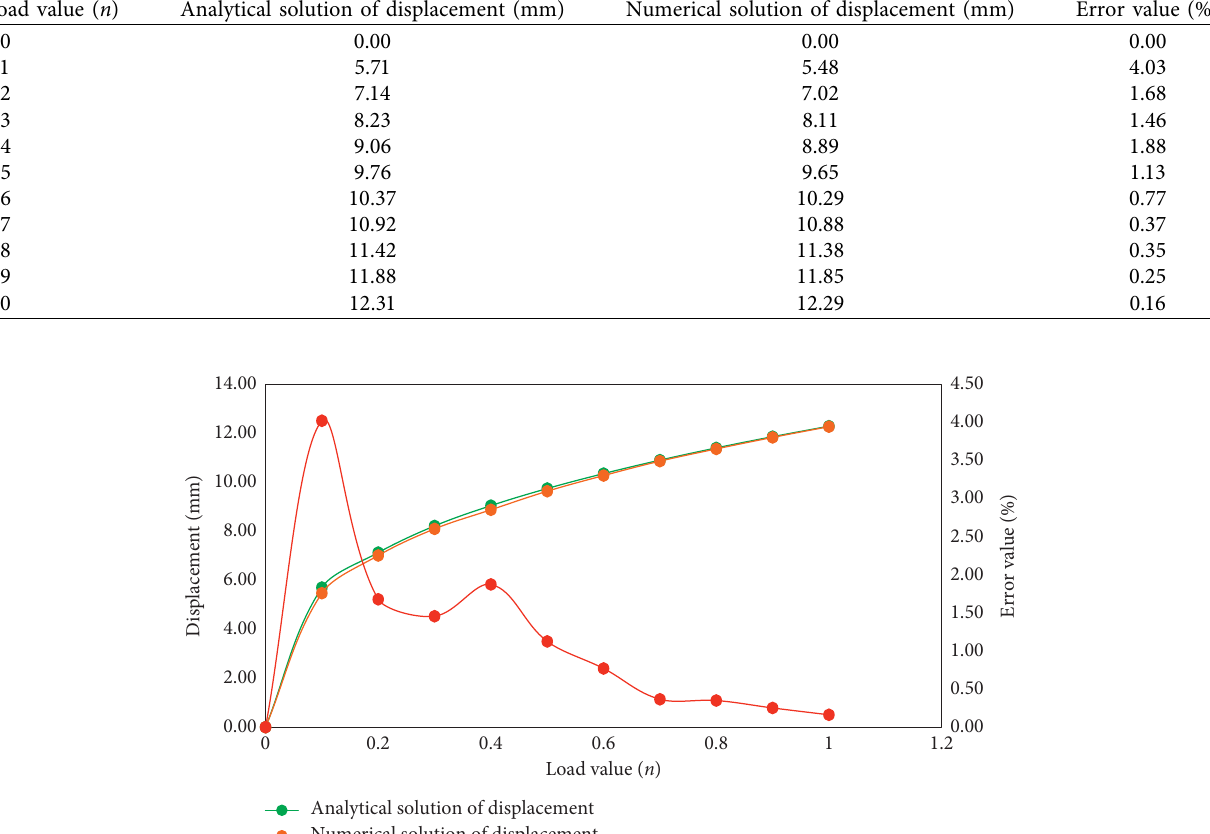
Table 5: Comparative analysis of numerical solution and analytical solution of unit point displacement of badminton racket.